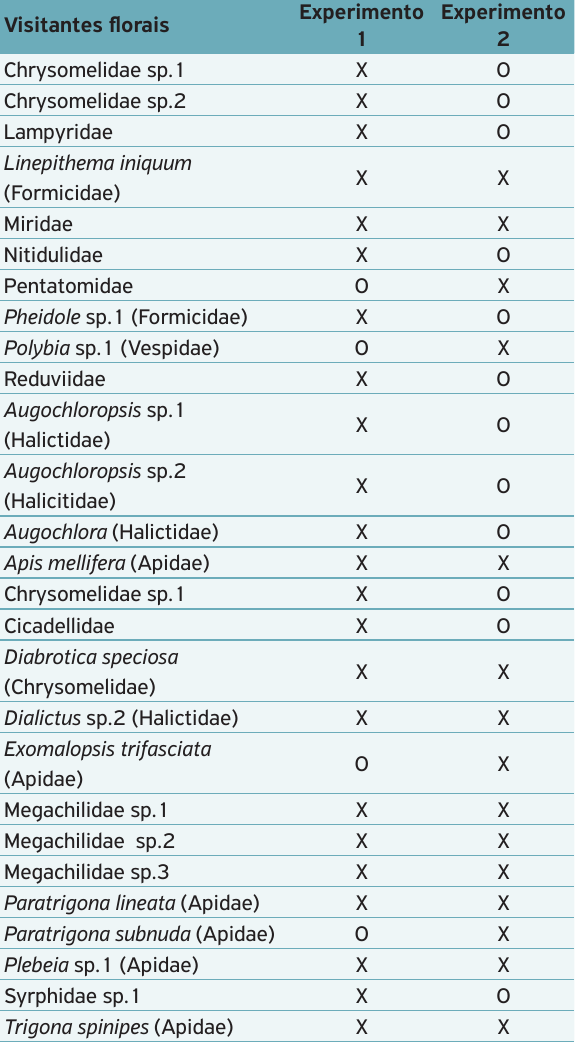
Tabela 5. Espécies de visitantes florais que ocorreram